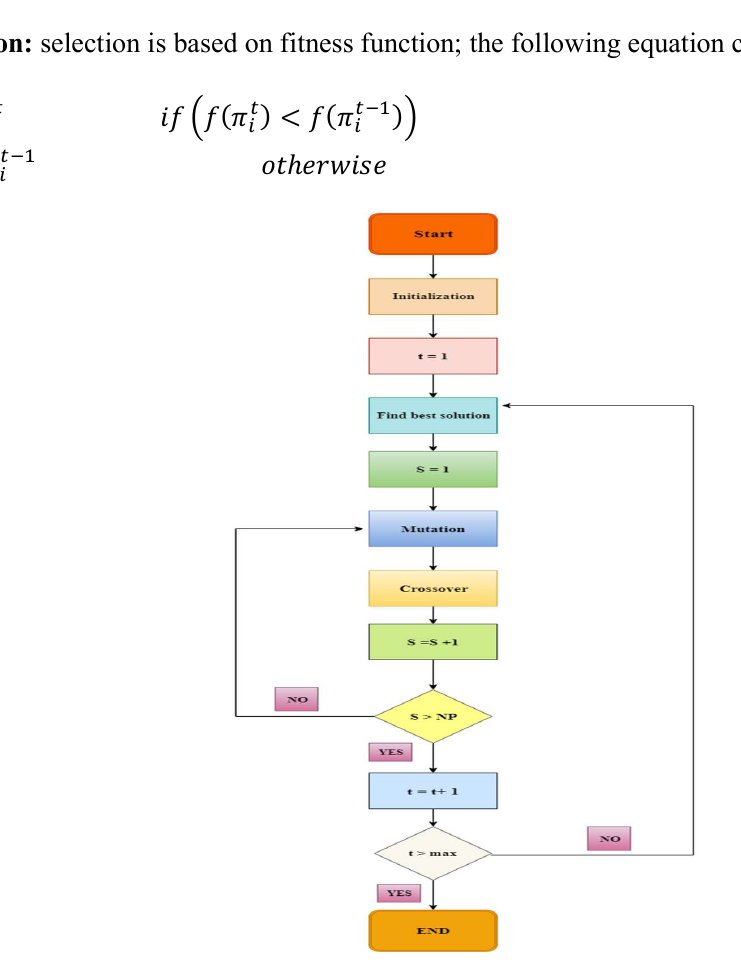
Fig. 1 . Flowchart of DDE